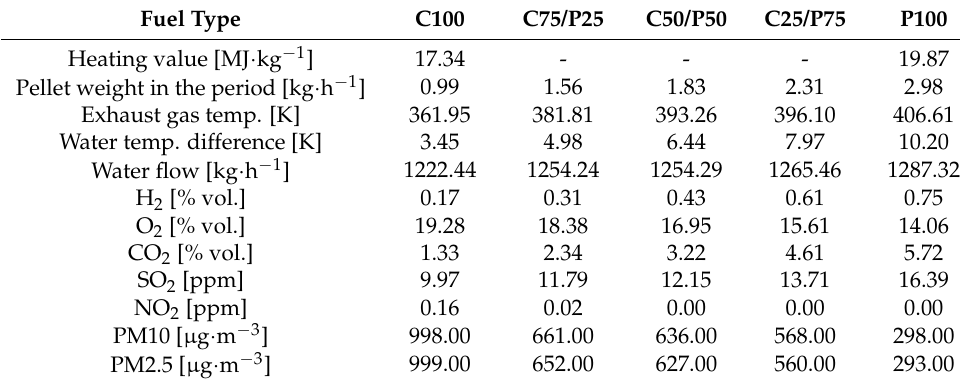
Table 2. Summary of study results.